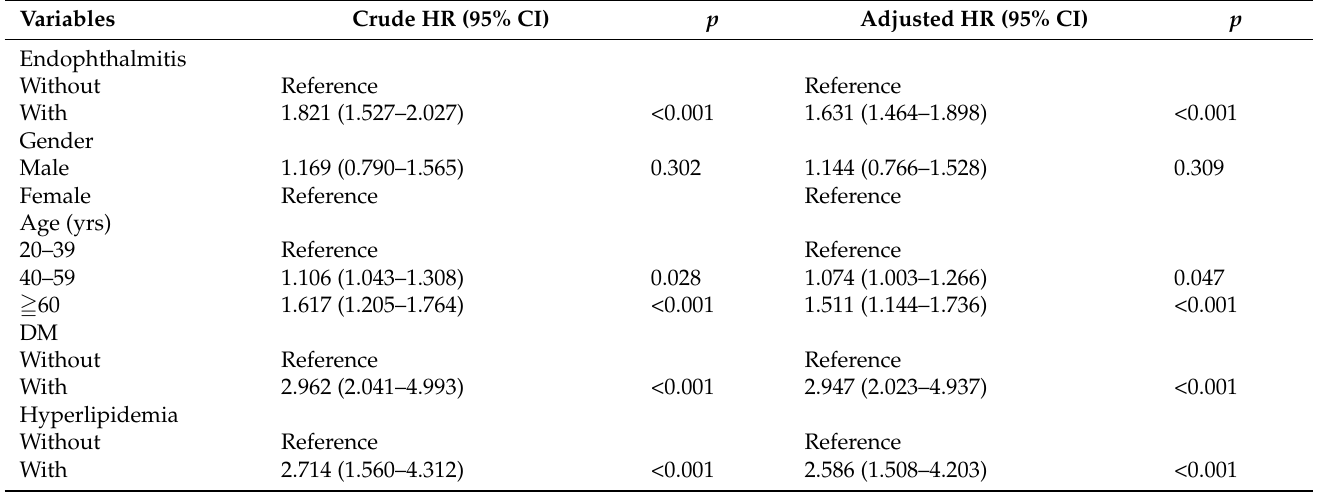
Table 2. AMI risk evaluation by Cox regression